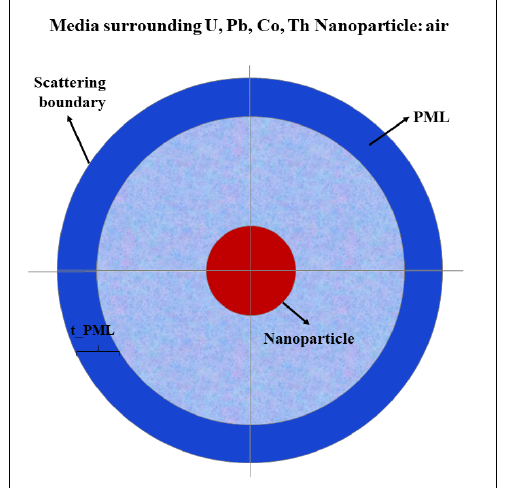
Figure 2. Schematic diagram illustrating the construction of the model for U, Pb, Co, and Th nanoparticle (layers are the thickness of PML, thickness of the air, and sphere radius).